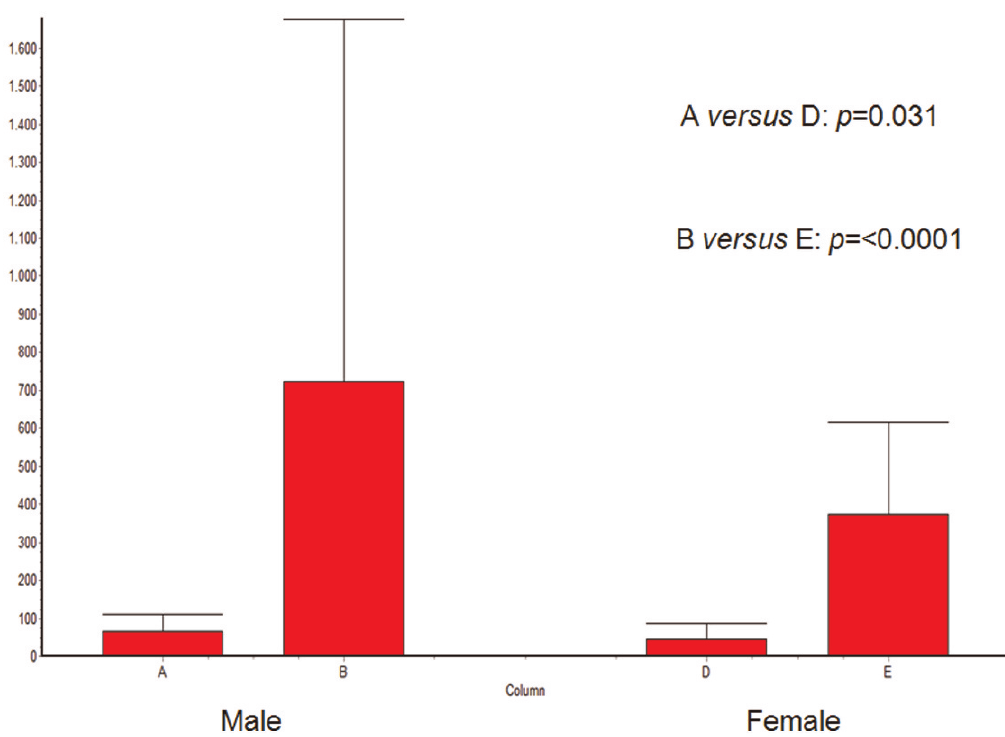
Figure 1 - Mean values of total IgE plasma stratified up to and above 140 IU/mL according to